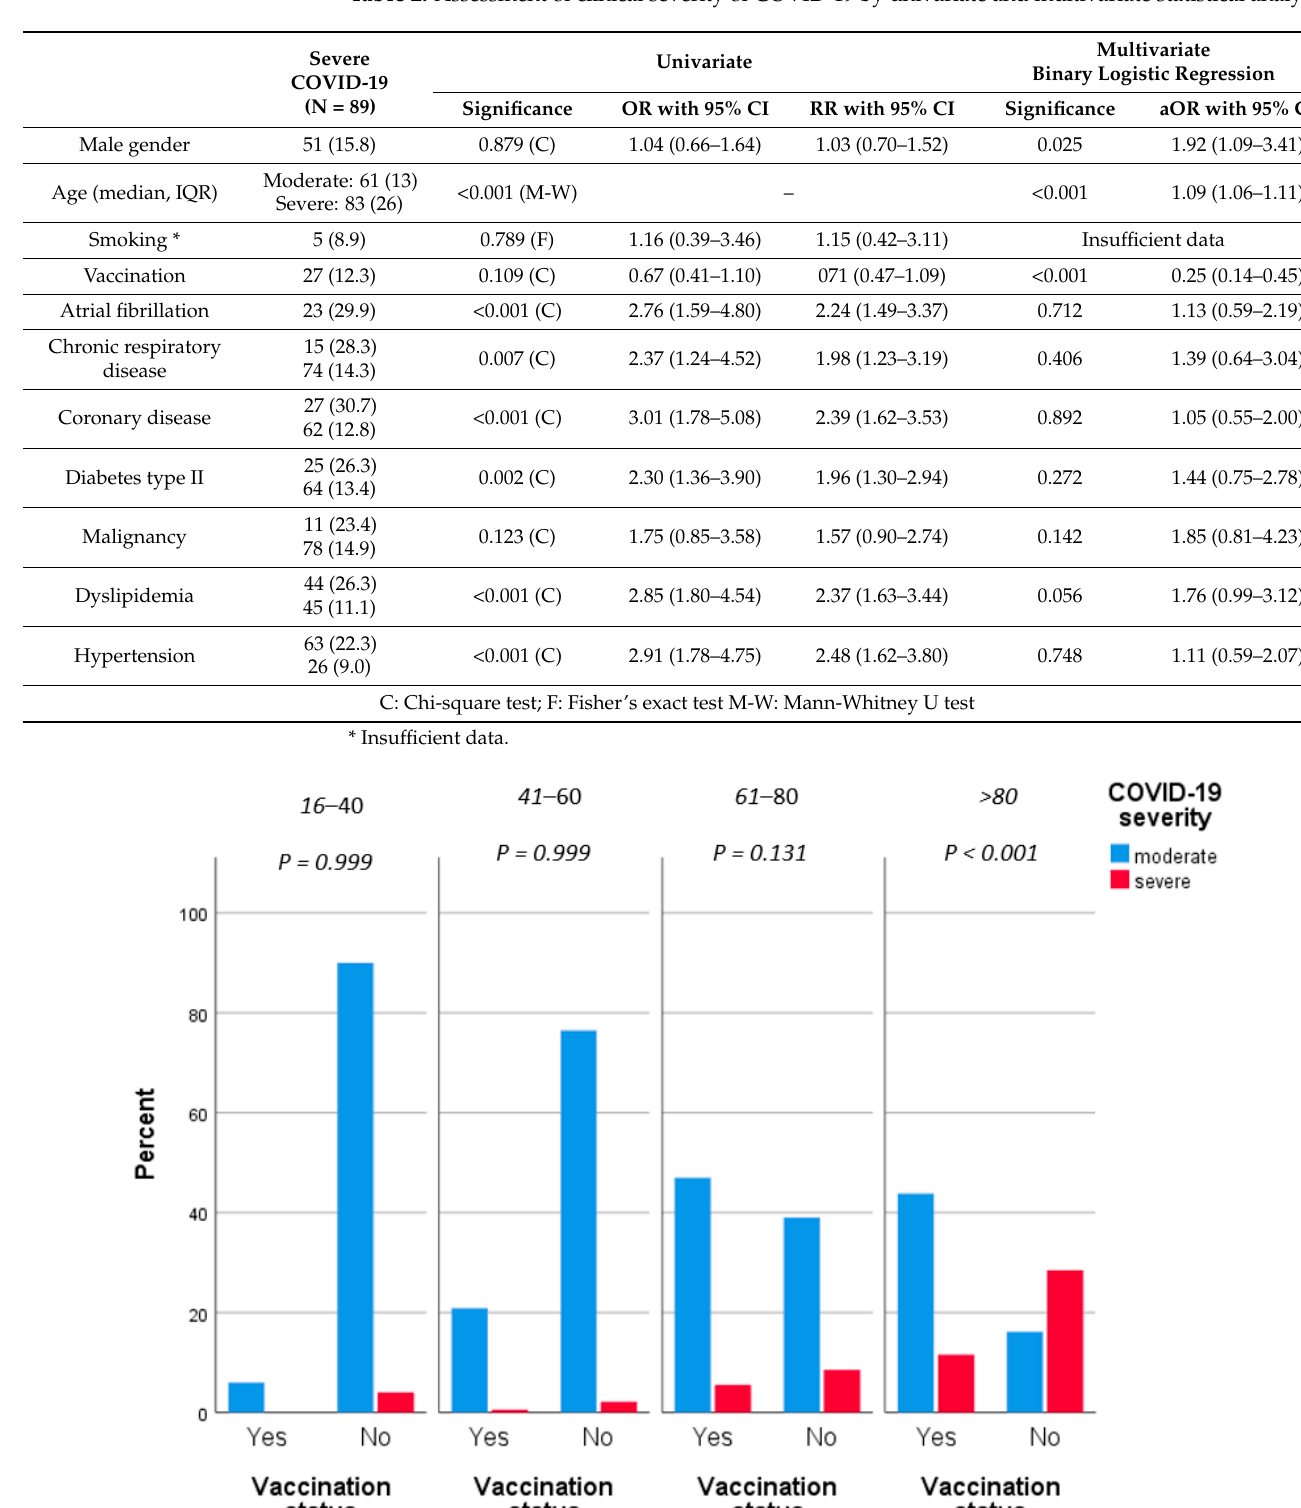
Table 2. Assessment of clinical severity of COVID-19 by univariate and multivariate statistical analysis.